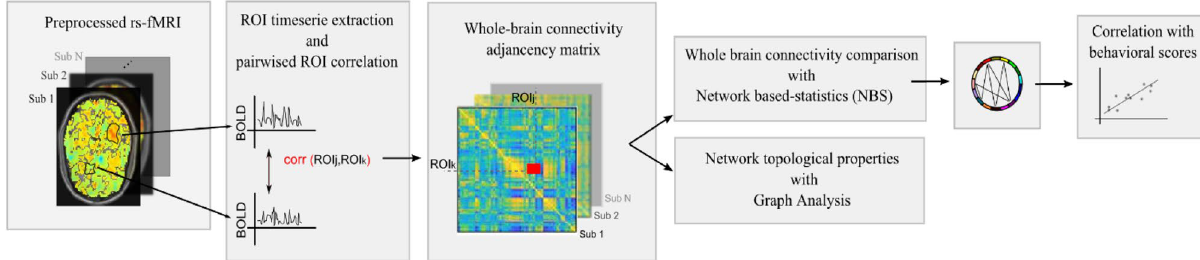
Figure 2. Diagram detailing the analysis